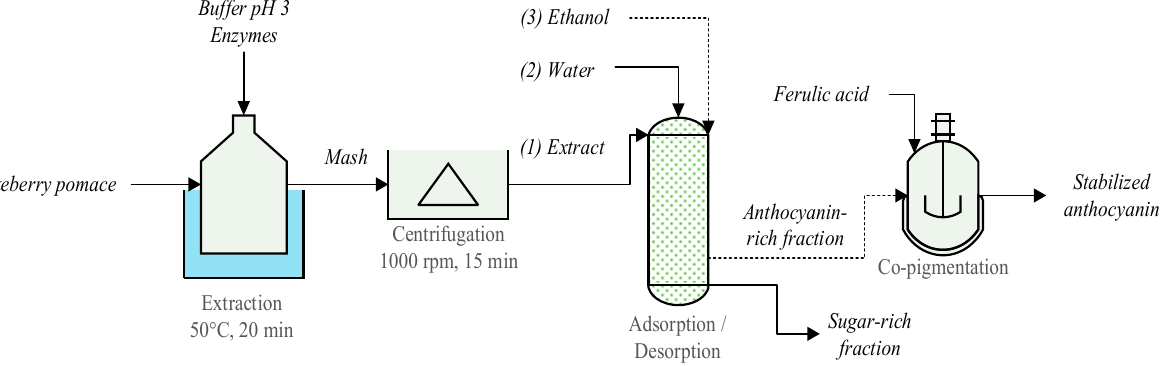
Figure 1. Proposed separation sequence for production of stabilized